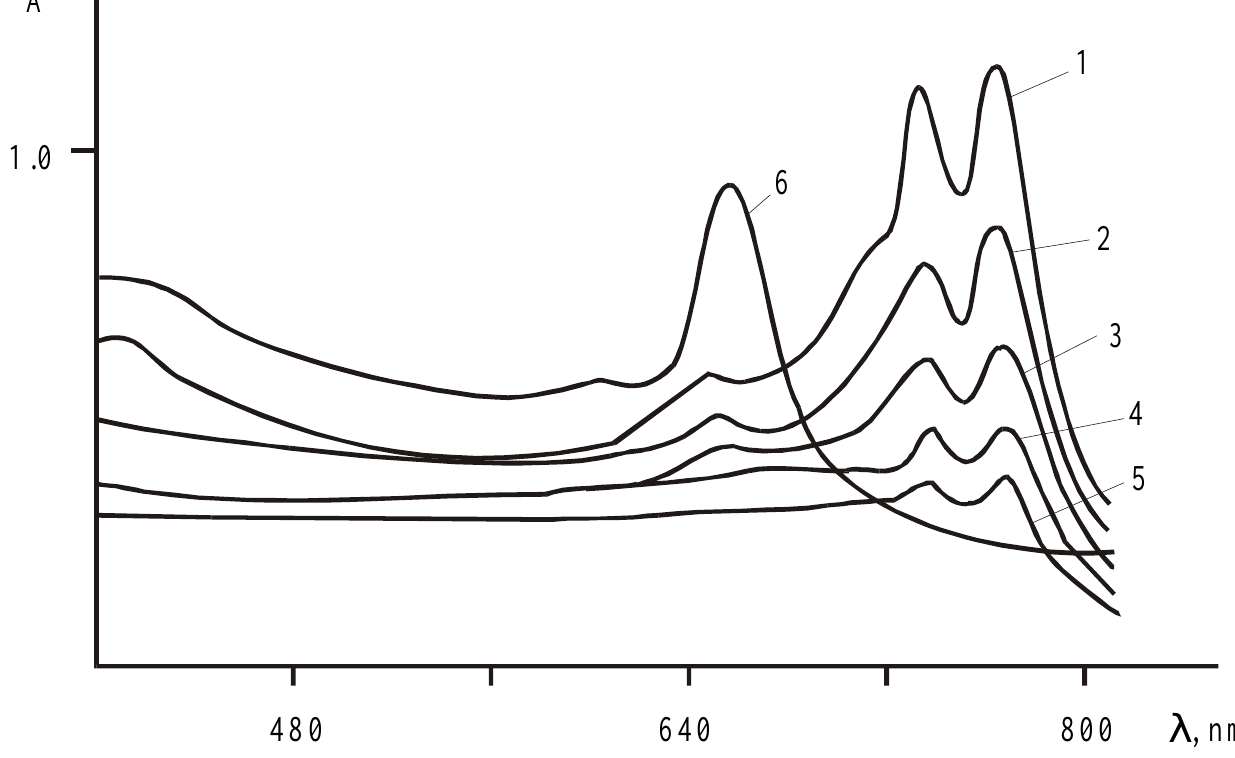
Figure 1. The electron absorption spectra of CuPc(4-NO s: 1 -1020, 2 - 1260, 3 - 1320, 4 - 1380, 5 - ¥ and in pyridine, T = 298K